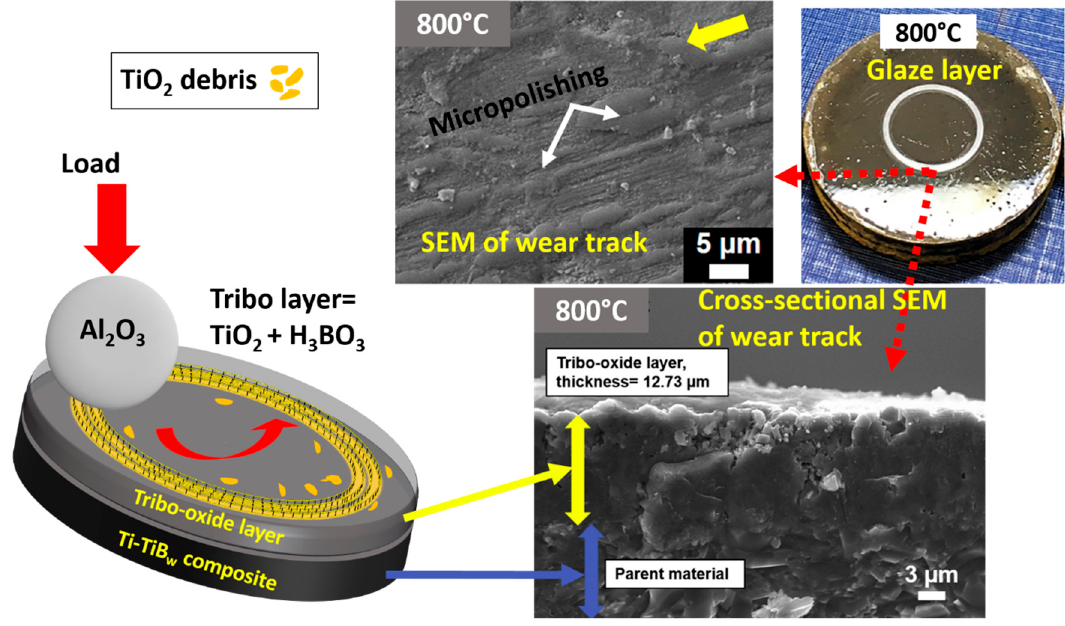
Figure 11. A collection of images from ref. [4] showing the mechanism of wear reduction at HT due to the formation of thick, homogeneous tribolayer. Tribolayer consisted of TiO 2 and boric acid.